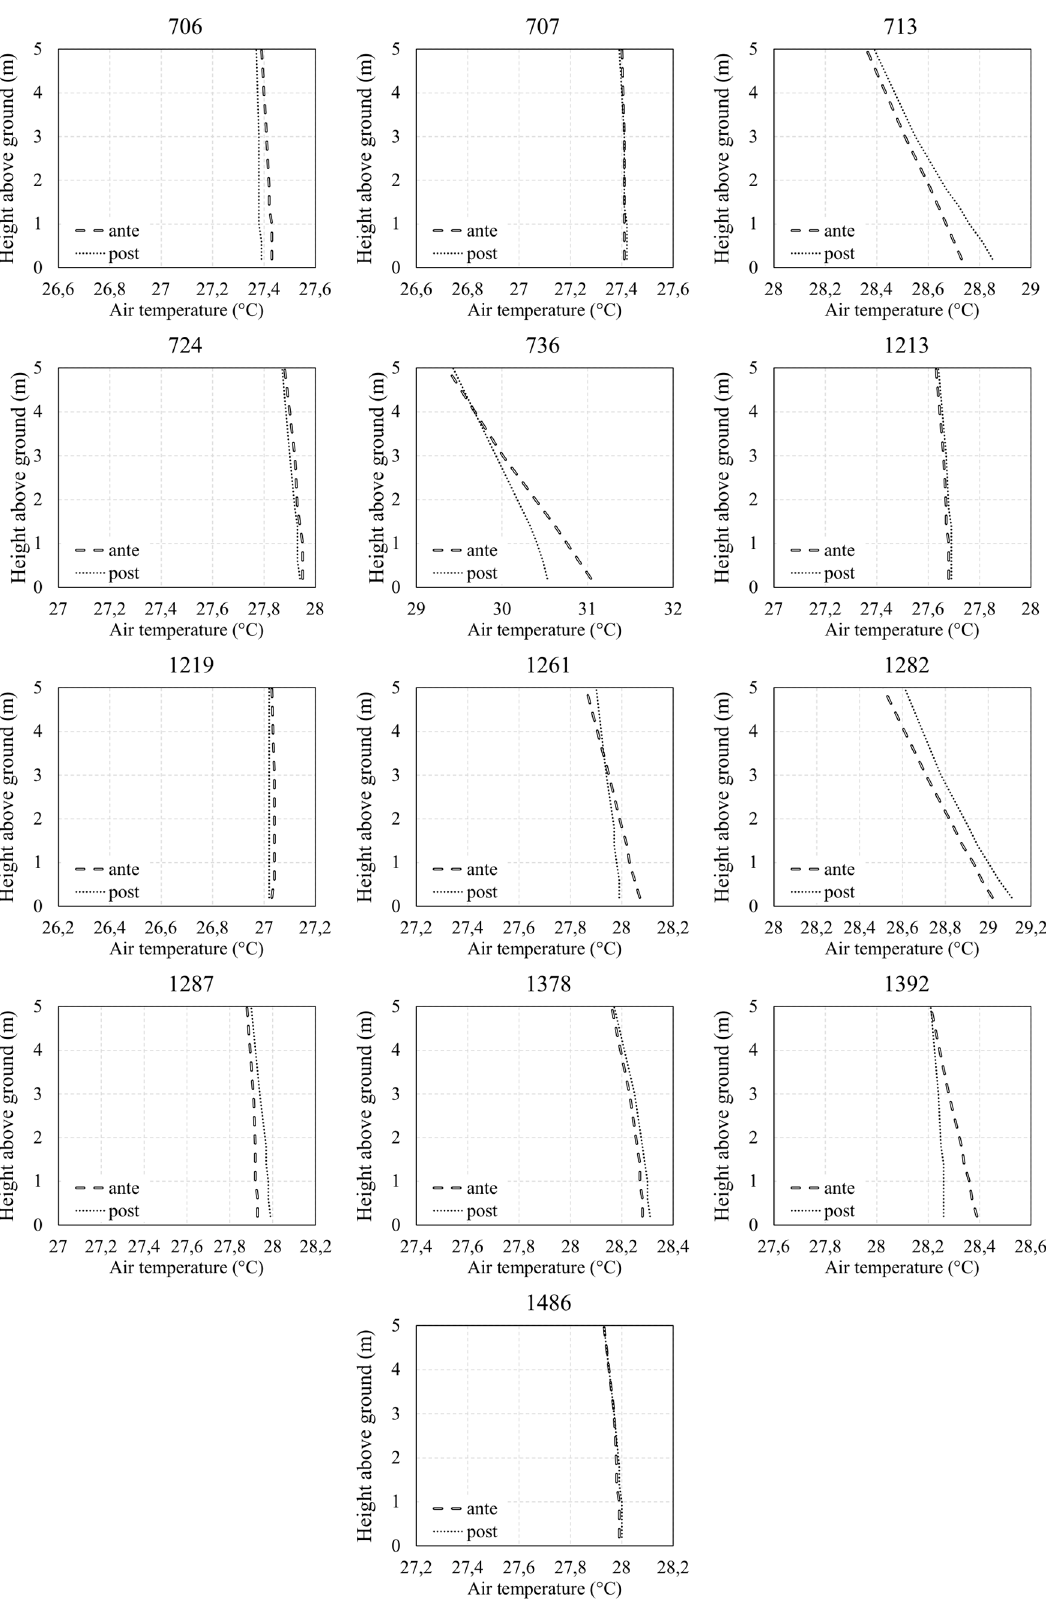
Figure 6. Altitude air temperature variations from ante to post-operam with trees.